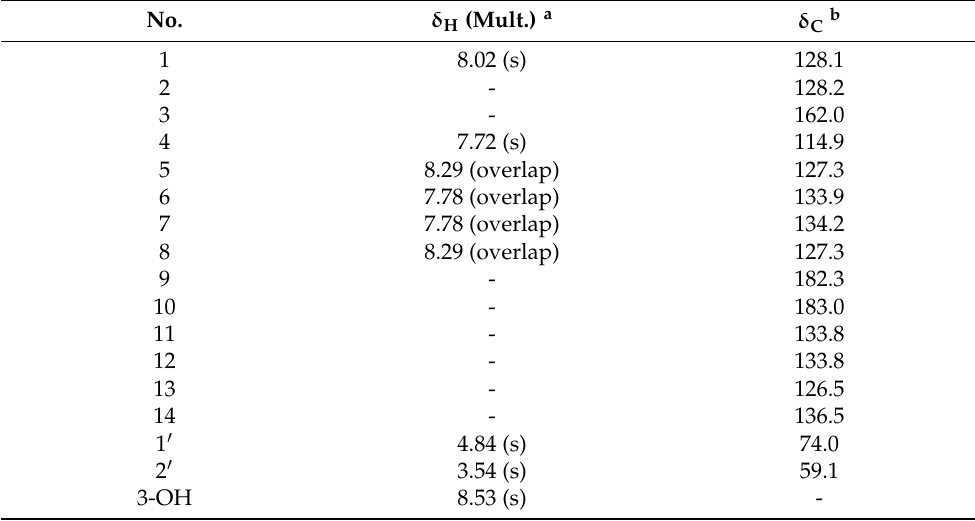
Table 1. 1 H NMR ( δ H ) and 13 C NMR ( δ C ) data of compound 1 in CDCl 3 .